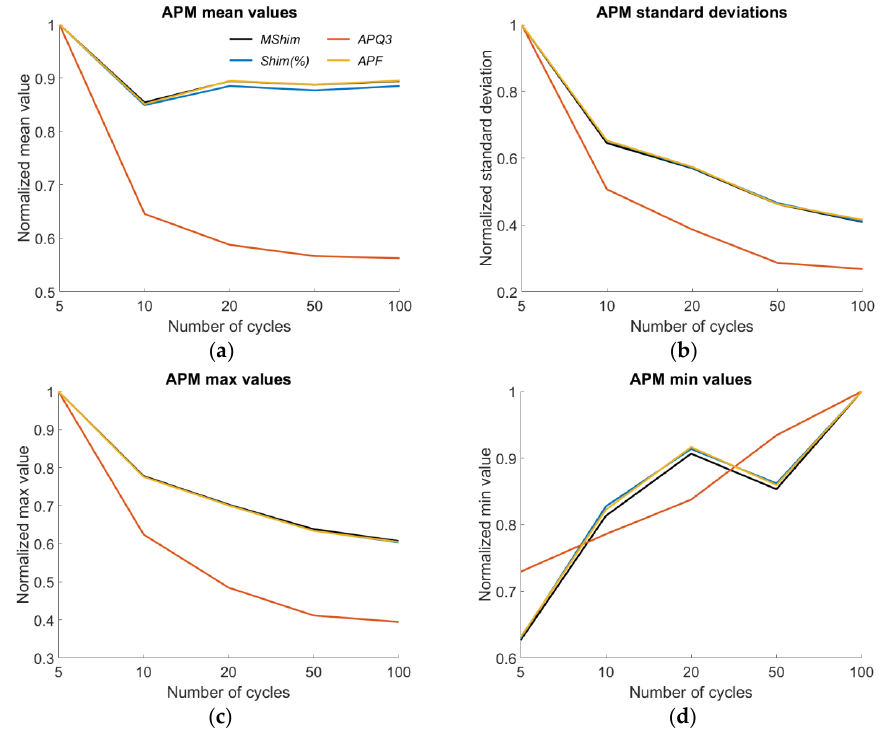
Figure 6. Amplitude Perturbation measures (APM) with exception of Amplitude Variability Index (AVI) : ( a ) normalized group means, ( b ) standard deviation, ( c ) maximum value, ( d ) minimum value.